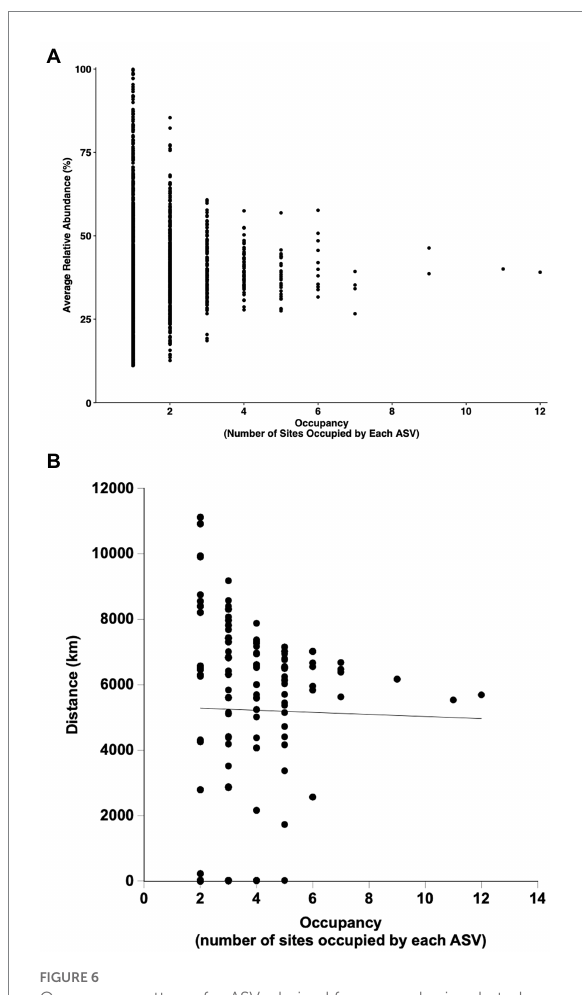
FIGURE 6 Occupancy patterns for ASVs derived from samples incubated under thermophilic conditions as a function of mean relative abundance (A) and mean distances among sites occupied (B)